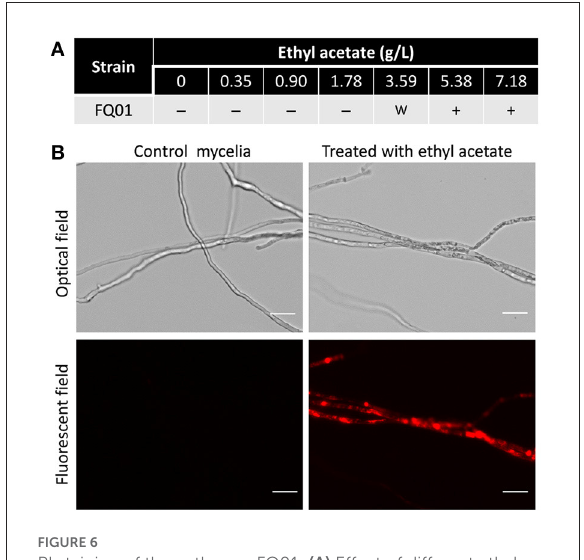
FIGURE6 PI staining of the pathogen FQ01. (A) Effect of different ethyl acetate concentration on PI staining. –, negative; w, weak; + , positive. (B) Images of the pathogen FQ01 after PI staining. Mycelia treated with 5.38 g/L ethyl acetate. Bars represent 20 µ m.